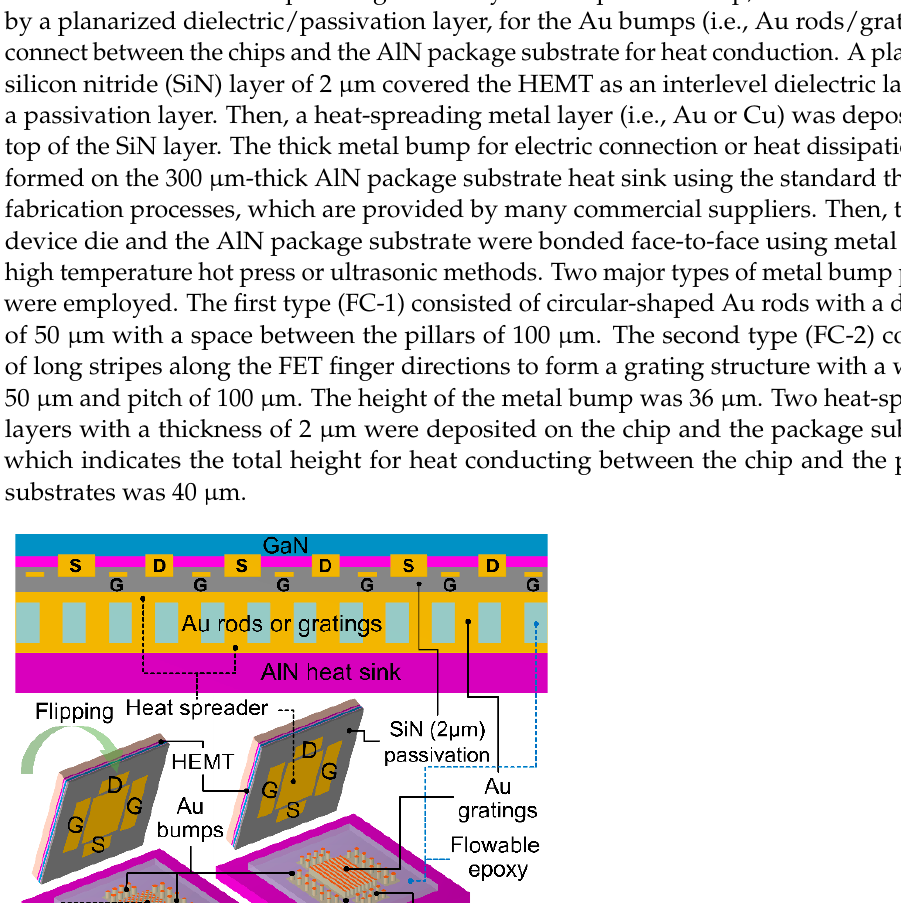
of a multiple gate HEMT device. ( c ) The drain current–voltage curve and corresponding power den-